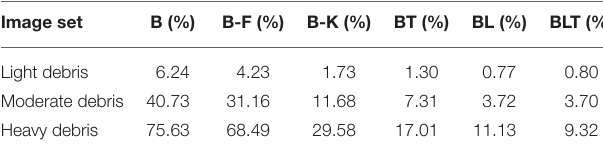
TABLE 2 | Classification error for all of the models on single digit detection with varying levels of debris.